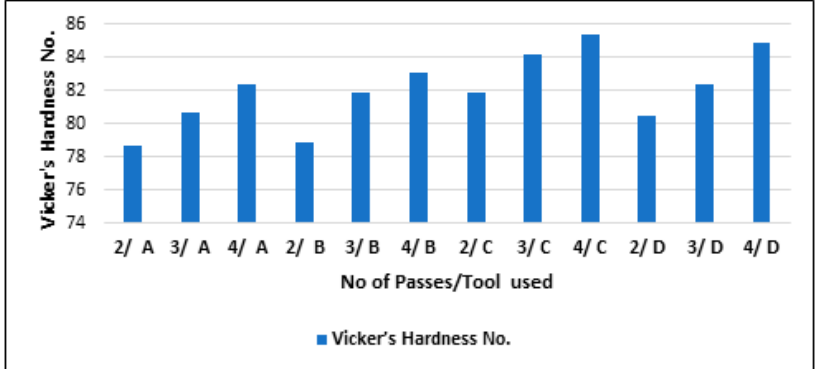
Figure 12. Vicker’s hardness number (HV) of the composites processed for a varying number of FSP passes.